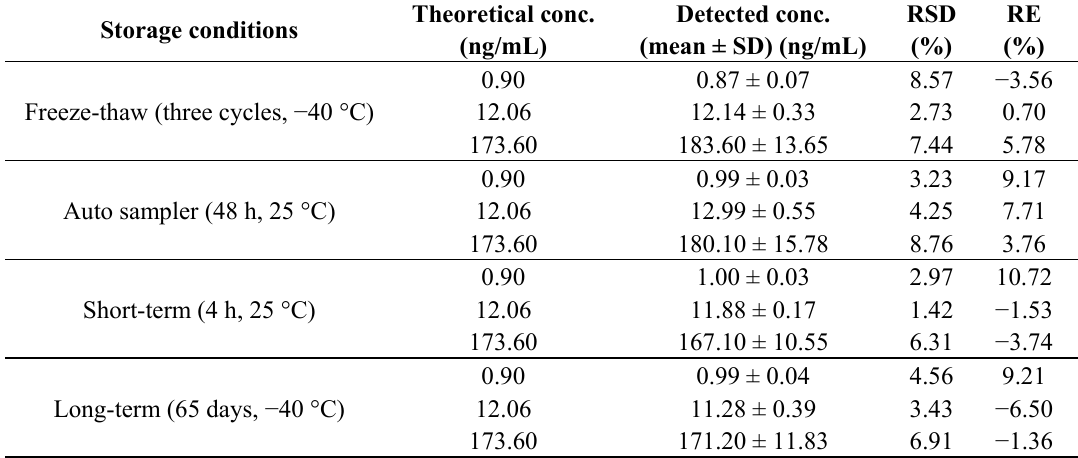
Table 3. Stability results for ATRA under different conditions (n = 5).